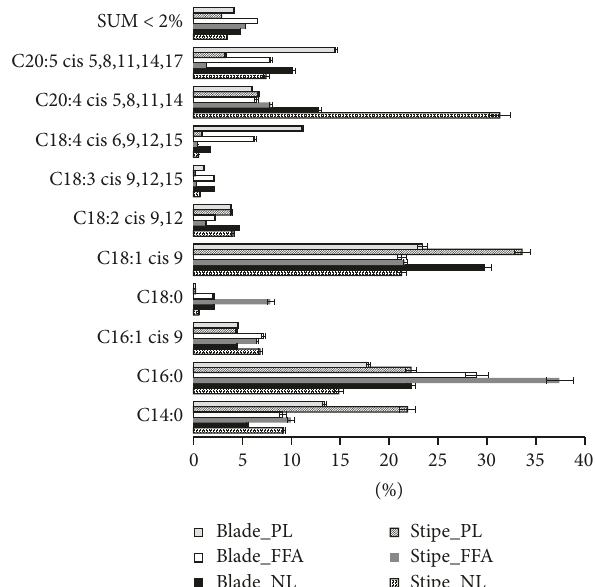
Figure 1: Fatty acid profile for fatty acids contributing more than 2% of total fatty acid content, in at least one lipid fraction. SUM < 2% is the summarized contribution of the remaining fatty acids ( 𝑛 = 4 , two injection parallels for each of these four sample replicates, error bars = ± SD). NL, neutral lipid; FFA, free fatty acid; PL, polar lipid.